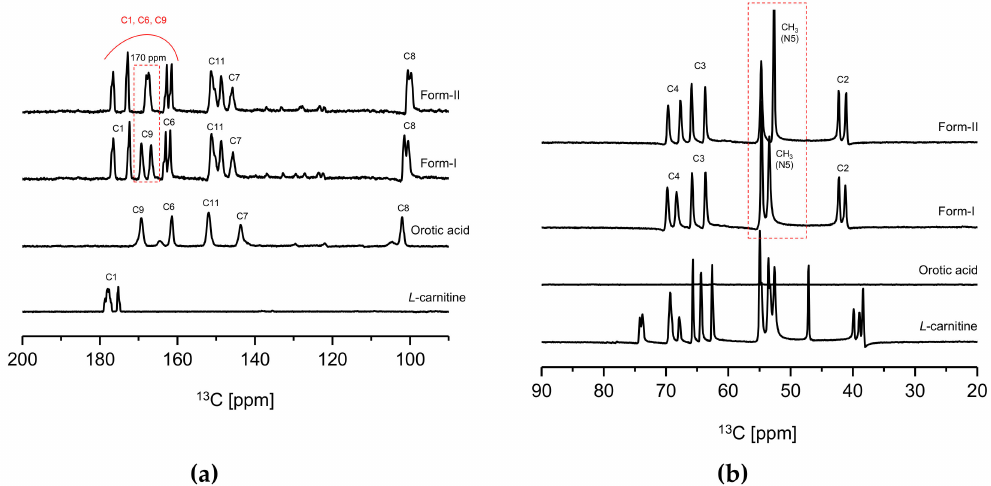
Figure 5. Solid-state CP/MAS 13 C-NMR data of CO polymorphs: ( a ) 90 ppm–200ppm, ( b ) 20 ppm–90 ppm (numbers on spectral peaks refer to numbers in Figure 1c structure and peak